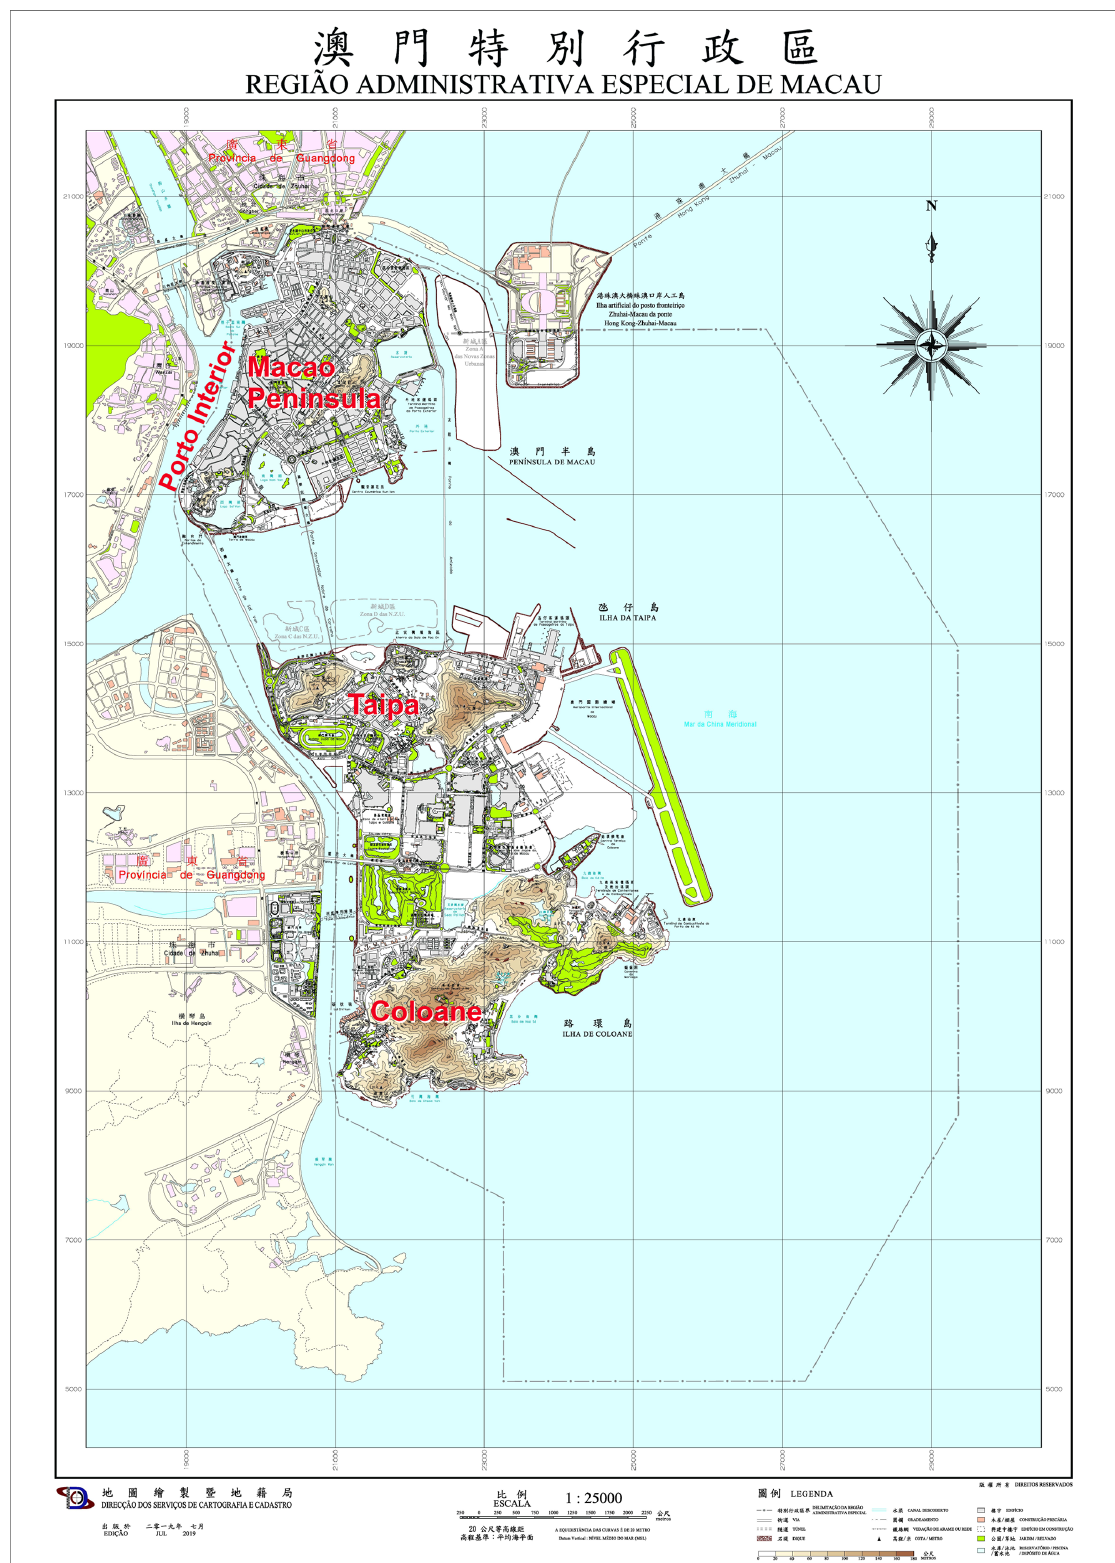
Figure 3. Topographic map of Macao in 2019 (© Macao Special Administrative Region Government – Cartography and Cadastre Bureau) showing the locations of Porto Interior, Macao Peninsula, Taipa, and